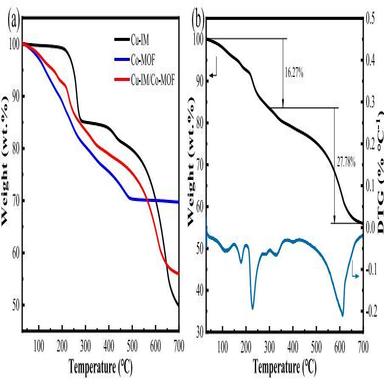
(a) TGA curves of Cu-IM, Co-MOF, and Cu-IM/Co-MOF, (b) TGA and DTG curves of Cu-IM/Co-MOF.